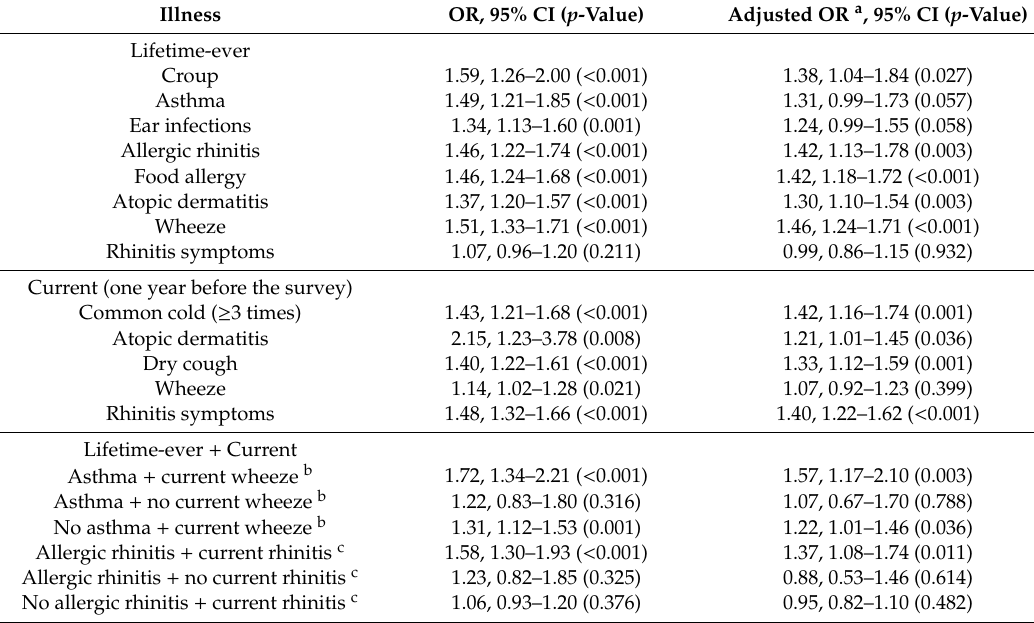
Table 5. Associations between first-year antibiotics exposure and childhood asthma, allergies, and airway illnesses, among children without lifetime-ever